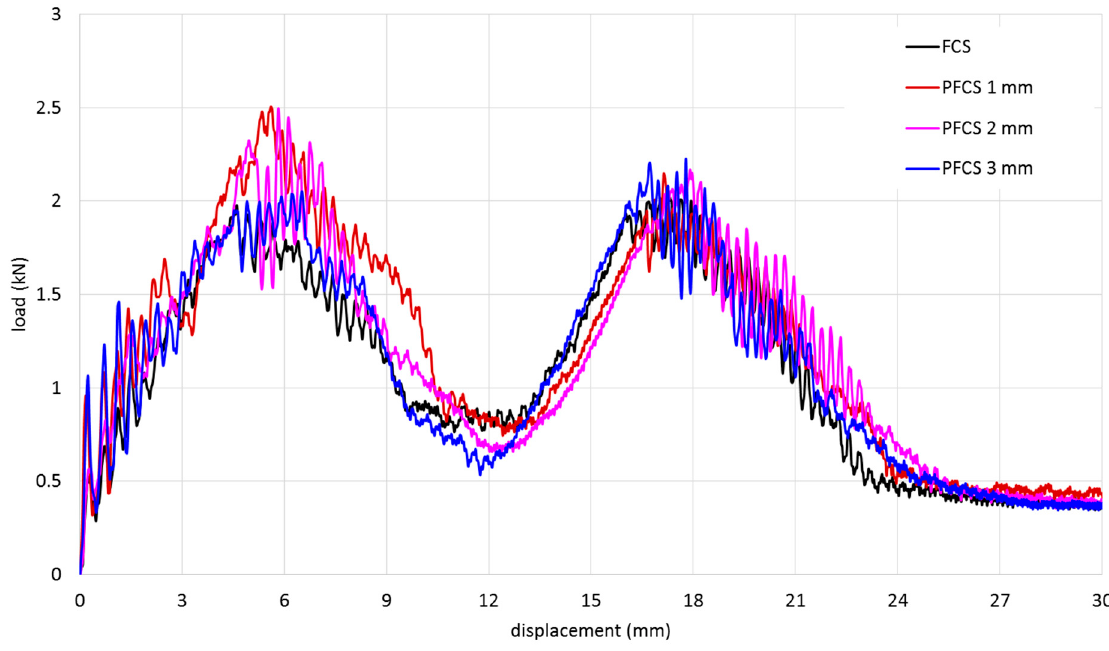
Figure 8. Comparison between experimental results of FCS and PFCS subjected to 500 mm/min.